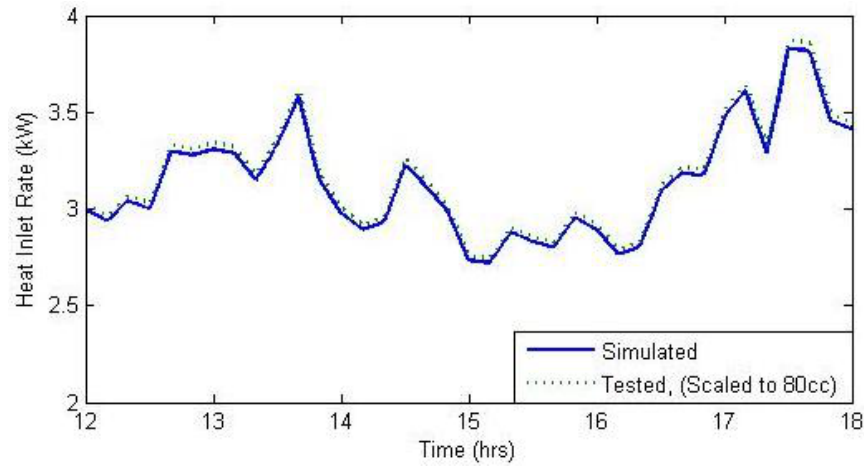
Figure 9. Plots of the simulated and tested heat inlet rate as well as the electrical load vs. time.